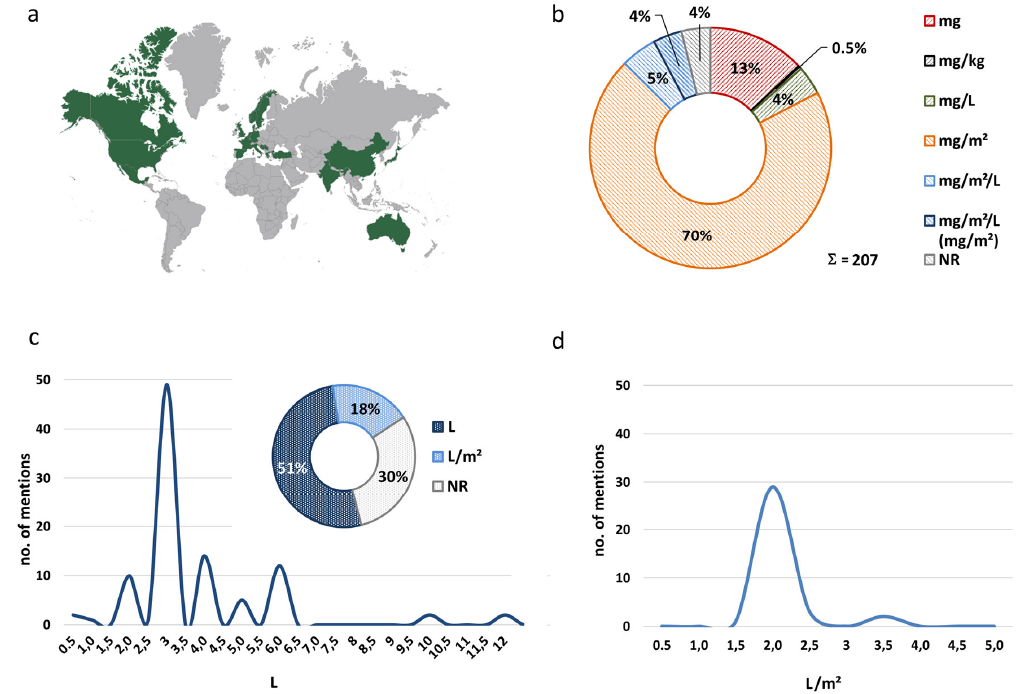
Figure 9. Overview of manuscript provenience, dosage specifications, and volumes of diluents: ( a ) Provenience of authors reporting HIPEC conduct in PM from CRC ( b ) Designations used for benchmarking drug dosages. ( c ) Volumes of diluents used for abdominal perfusion in L (x-axis) plotted against the number of mentions in publications (y-axis). The pie chart depicts percentages of HIPEC reports mentioning diluent volumes in L, L/m 2 , or with no further specification (NR). ( d ) Volumes of diluent used in L/m 2 (x-axis) plotted against the number of mentions in publications (y-axis). Numbers were rounded to one half of a percent. Abbreviations used: NR (not